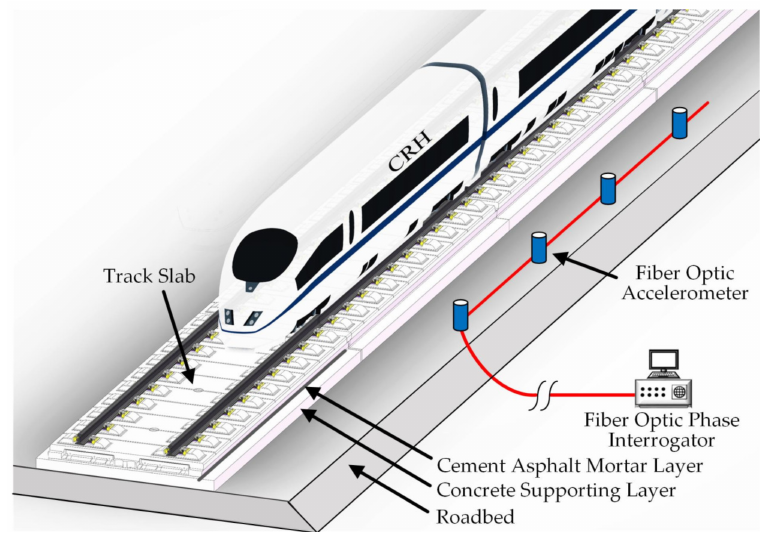
Figure 1. Composition of the experimental